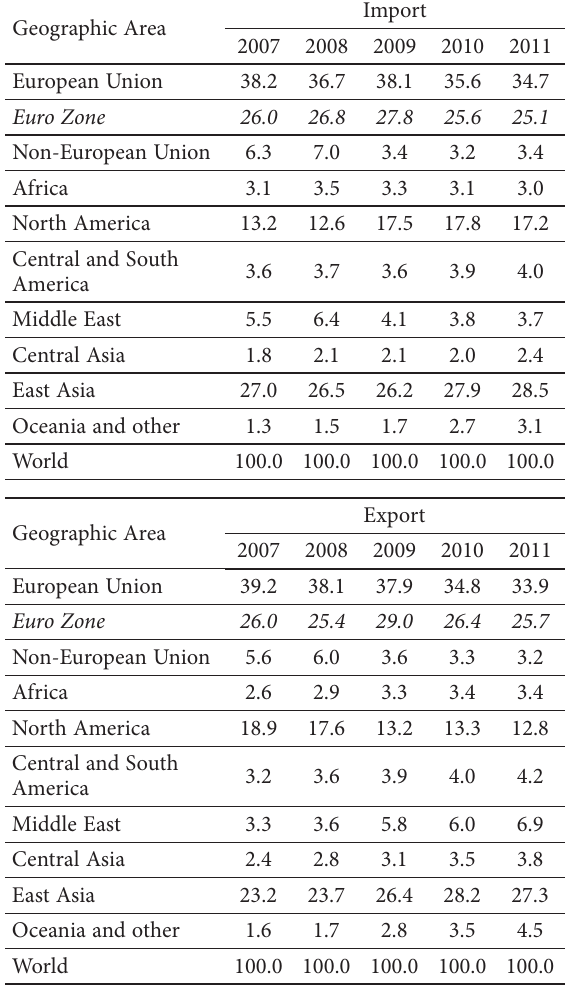
Table 1. Distribution of import/export flows (share respect to current